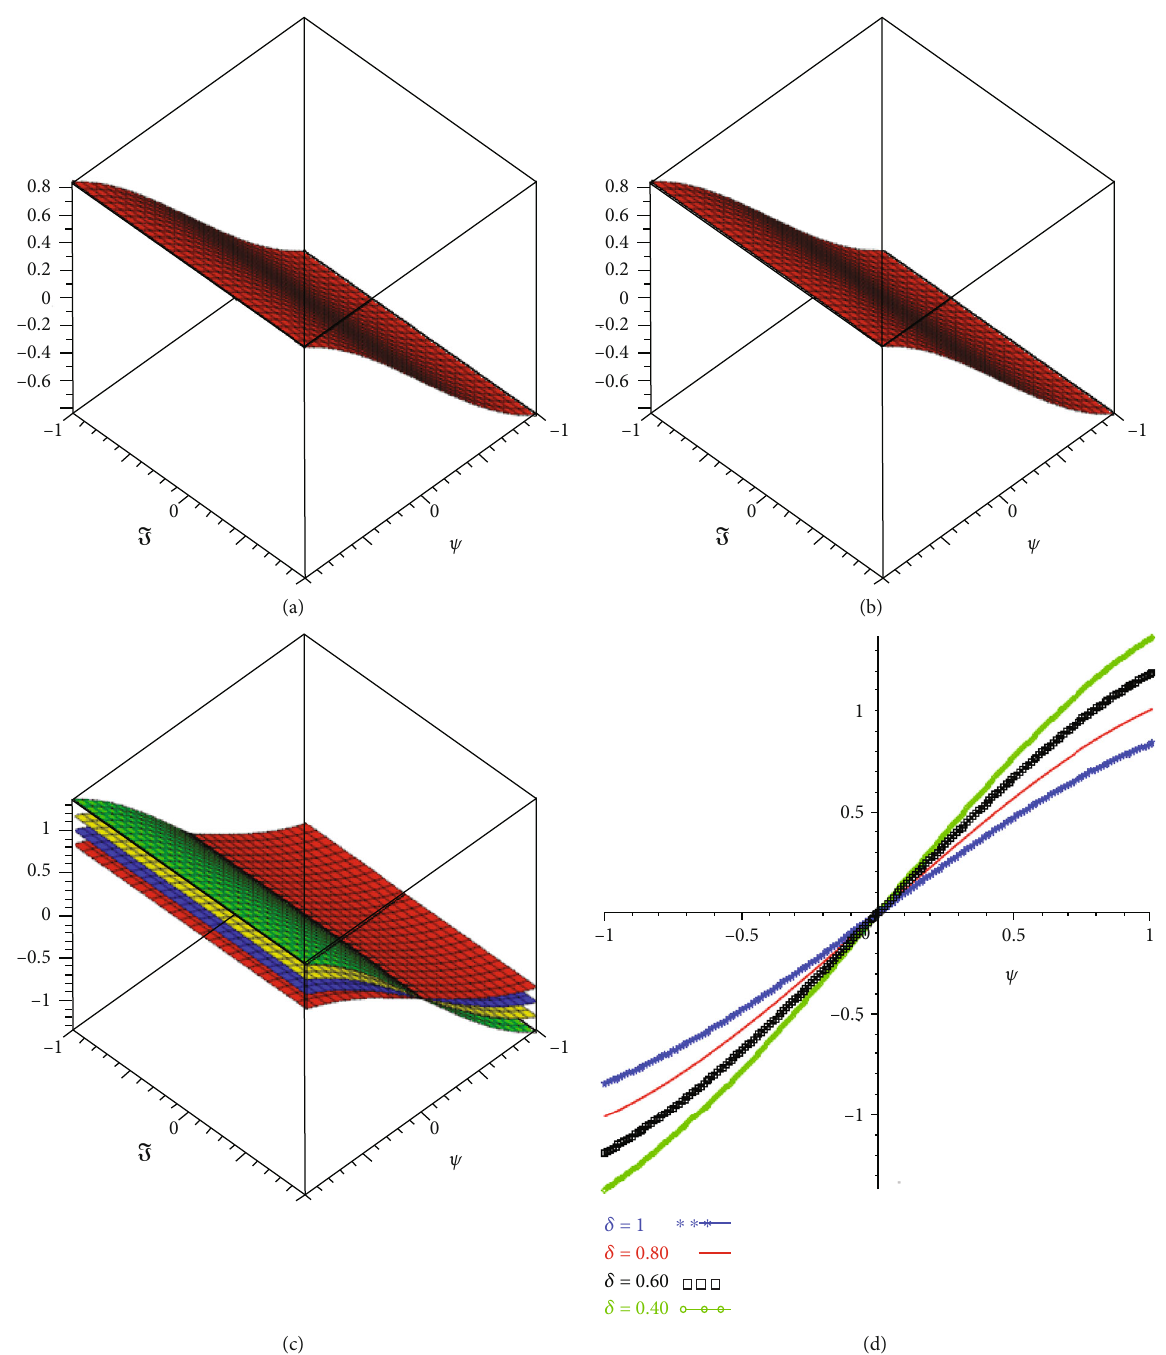
Figure 3: Example 3 solution graph (a) exact solution, (b) analytical solution at δ = 1, (c) analytical solution at various fractional-orders of δ , and (d) I = 0 : 5